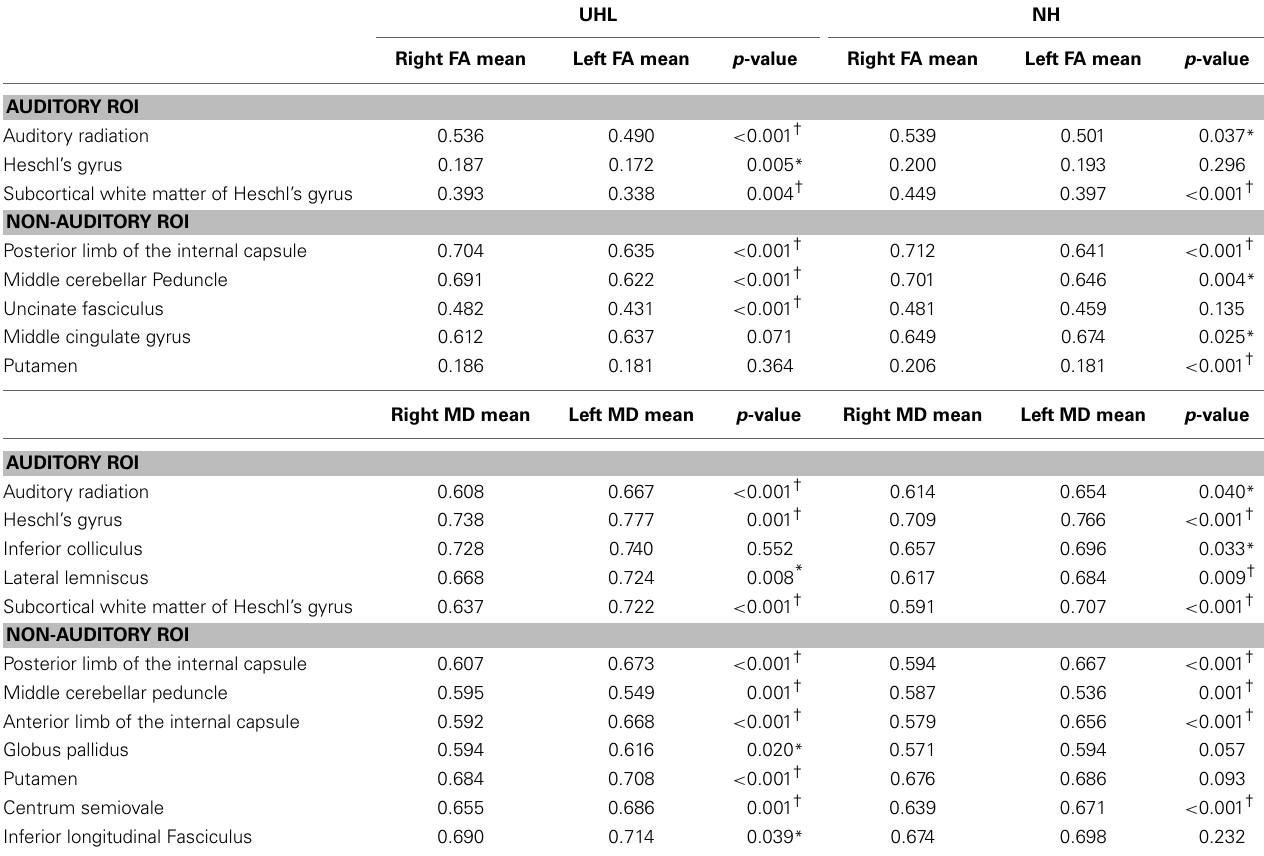
Table 5 | Comparison of fractional anisotropy (FA) and mean diffusivity (MD) between right and left hemispheres for unilateral hearing loss (UHL; n = 29) and normal hearing (NH; n = 20) participants in six auditory and nine non-auditory regions of interest